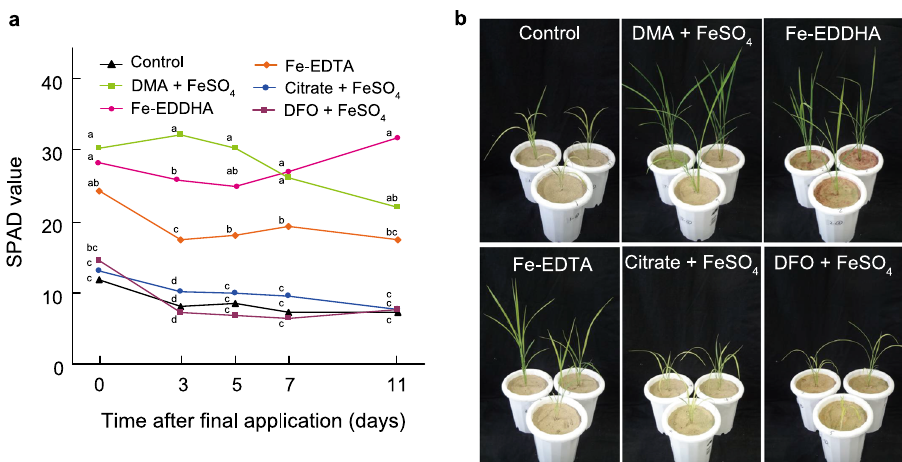
Fig. 2 Effects of DMA application on plant growth in calcareous soil. a Soil and plant analyzer development (SPAD) values of the newest rice leaves after the last of six applications of Fe-chelates at 14 days after transplantation (0 days after the last application). The chelates (DMA, citrate, and desferrioxamine [DFO]) were mixed with equimolar FeSO 4 in water before application. Values are means of three replicates in which each replicate is average of three plants in each pot, and different letters at the same time point indicate signi fi cant differences at P < 0.05 by Tukey ’ s honestly signi fi cant difference test (two-sided). P -values for one-way analysis of variance (ANOVA) are follows: 0 days, 0.0001; 3 days, <0.0001; 5 days, <0.0001; 7 days, <0.0001; 11 days, <0.0001. b Rice plants at 3 days after the last application. DMA 2 ′ -deoxymugineic acid, EDTA ethylenediaminetetraacetic acid, EDDHA ethylenediamine- N , N ′ -bis(2-hydroxyphenylacetic acid), DFO desferrioxamine, SPAD soil and plant analyzer